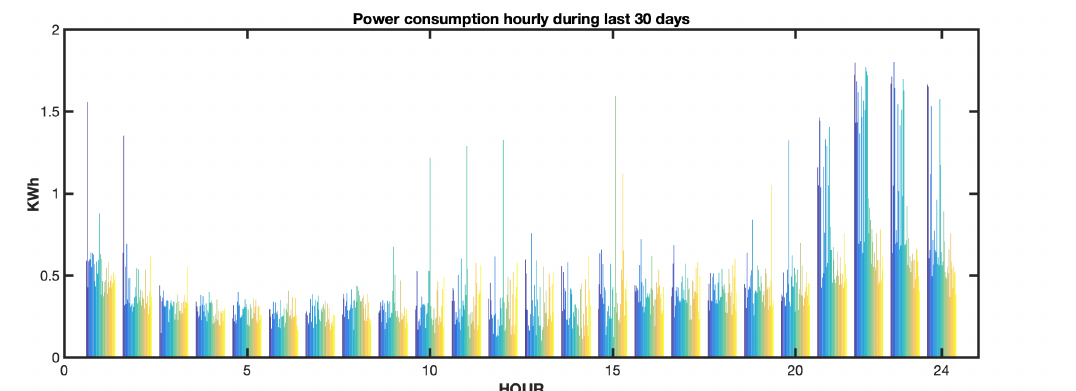
Figure 15. Power consumption dataset used to predict the consumption. For each hour of the day, on the x axis, the power consumptions during the last 30 days are shown. These data formed a dataset that was updated to be the input to the prediction